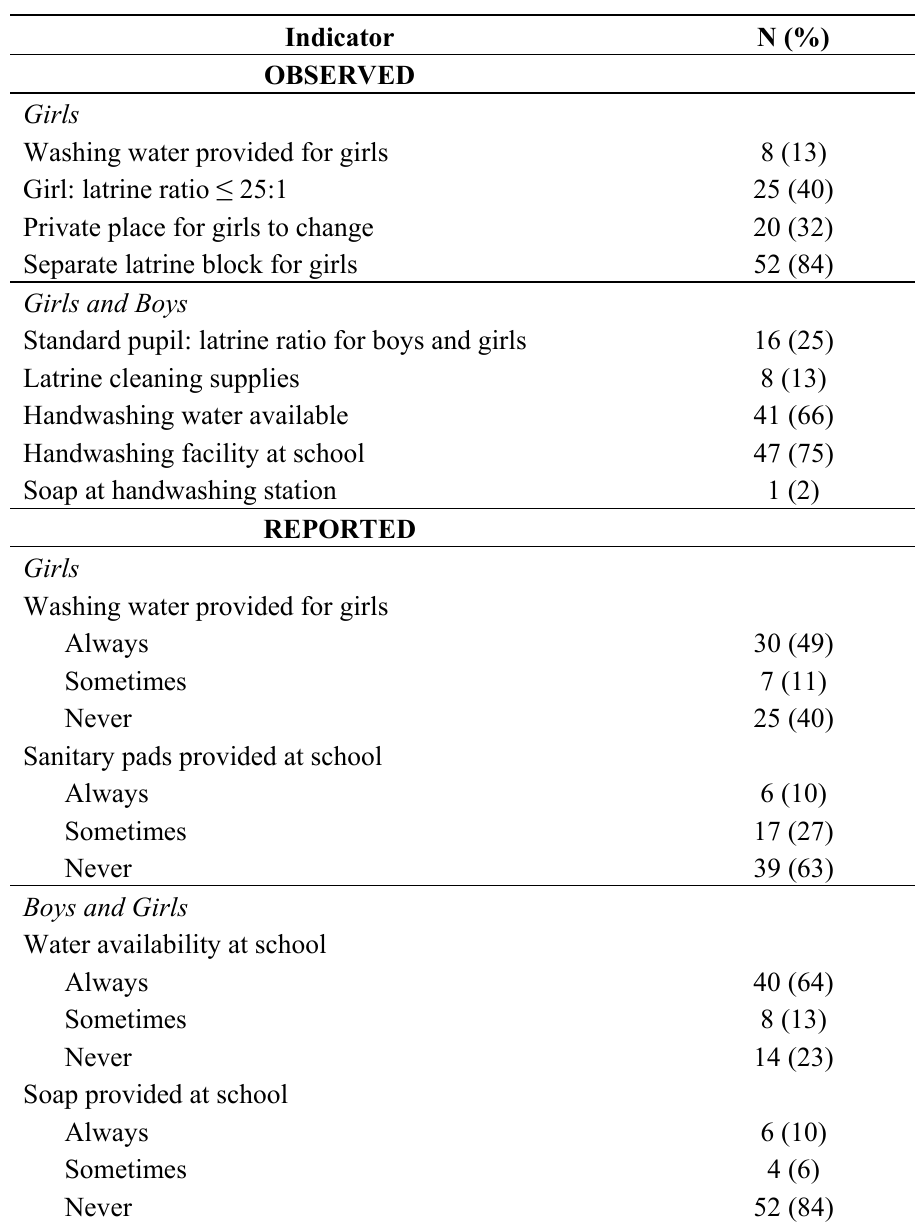
Table 1. Schools with specific water, sanitation and hygiene (WASH) facilities, including those for menstruating girls ( n =